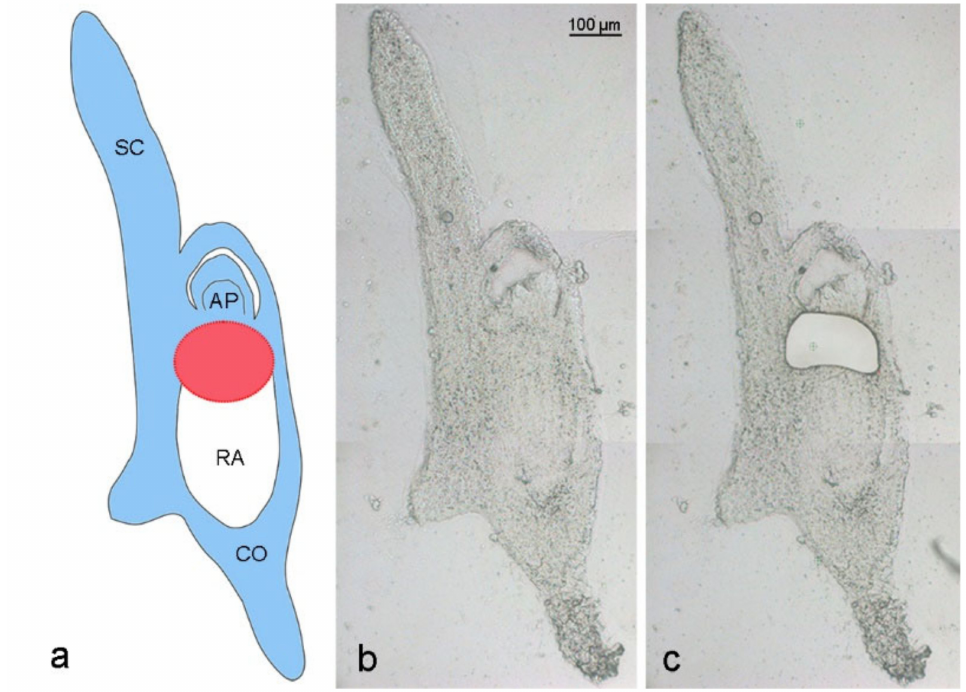
Figure 2. Laser capture microdissection of an Ae. speltoides embryo. ( a ) Schema is depicting an embryo with B chromosomes at the stage of 17 days after anthesis. Blue color indicates embryo parts containing Bs, white color shows the absence of Bs in the radicle. The red circle marks the region of ongoing Bs elimination between the apical meristem and developing radicle. SC—scutellum, AP—apical meristem, RA—radicle, CO—coleorhiza. Cryosection of a 17 DAA embryo ( b ) before and ( c ) after laser dissection of the region where Bs undergo